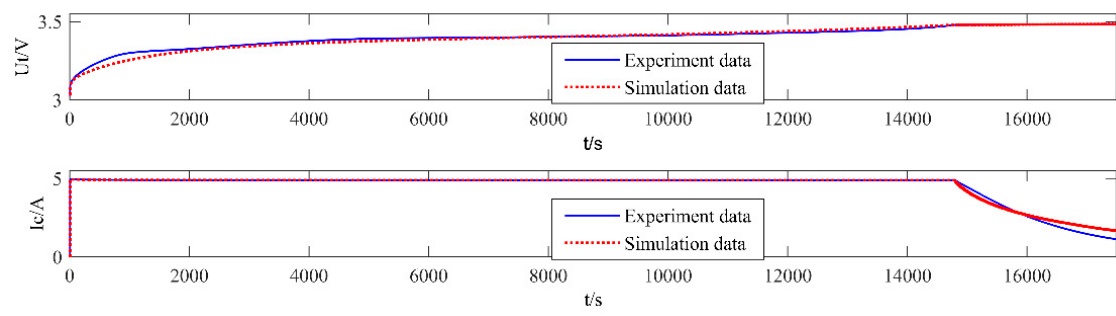
Figure 7. Comparison of experiment results and simulation results of charging in “constant current5 A-constant voltage 350 V”.